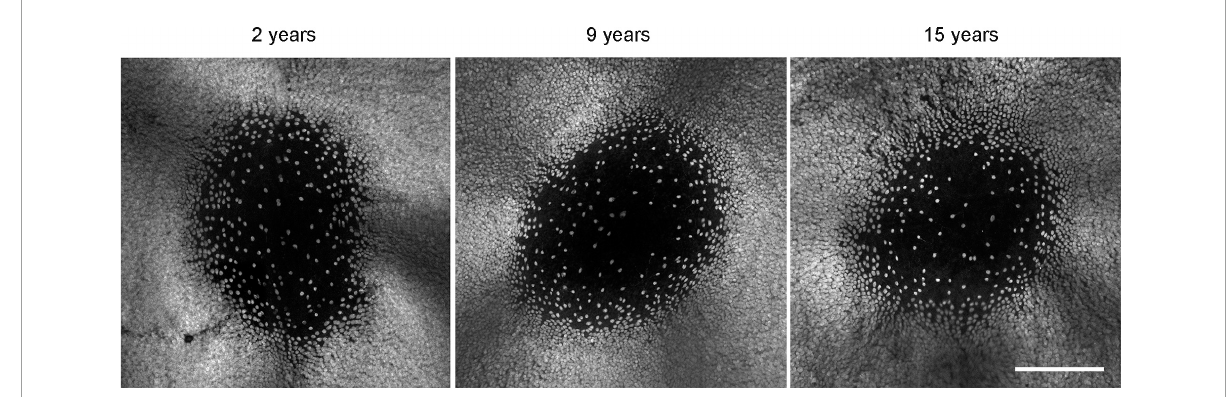
FIGURE6 RBPMS whole mount staining reveals no qualitative difference in foveal ganglion cell pattern at different ages. Scale bar, 200 µ m.